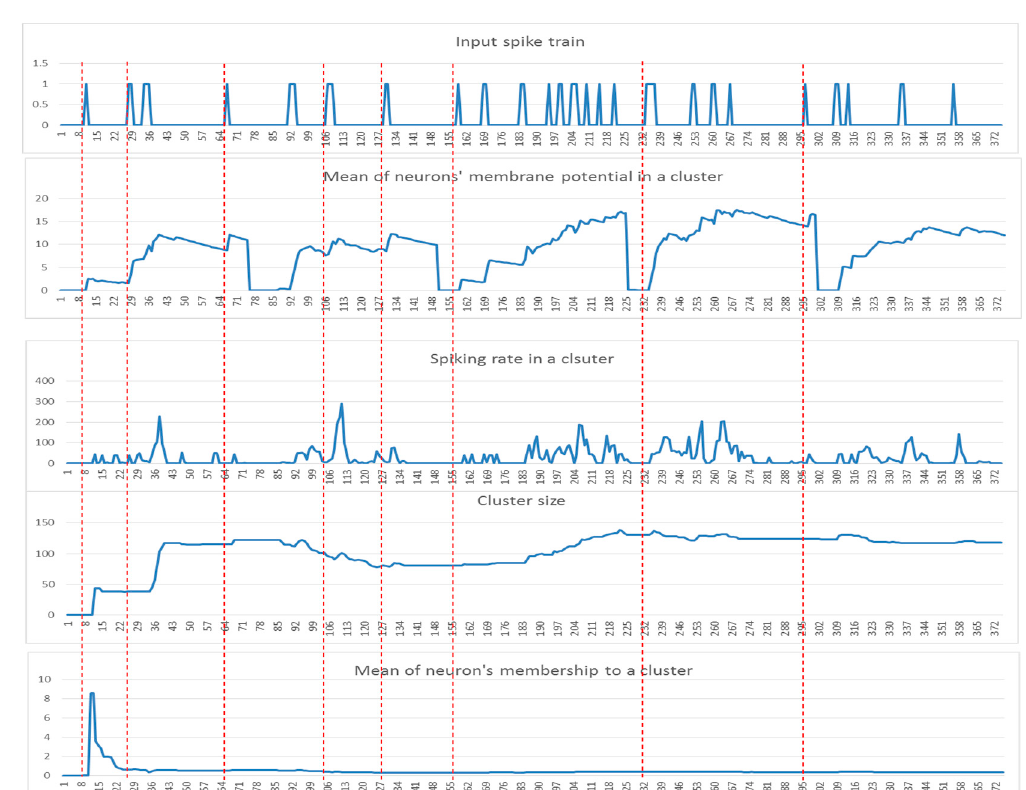
Figure 3. Examples of the five dynamic patterns: ( s t ) , ( µ PSP ( t ) ) , ( sr t ), the cluster size, and the neurons memberships of one cluster (for EEG channel T4) corresponding to a time-window of 75 time points for five samples from the control group.